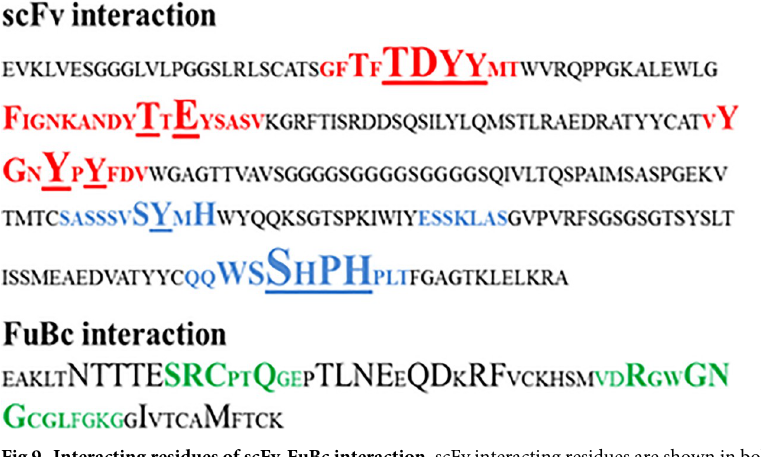
Fig 9. Interacting residues of scFv-FuBc interaction. scFv interacting residues are shown in bold with underline and level of interaction of each of these residues is represented by their size. Heavy chain CDRs are in red and light chain CDRs are in blue. FuBc interaction is shown in bold with bigger size. Fu and Bc loops are shown in green.